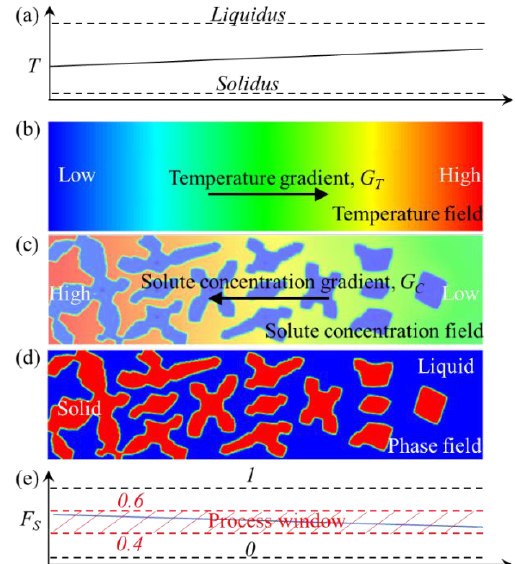
Figure 1. Schematic illustration of microstructure evolution under temperature gradient in mushy zones, ( a ) temperature distribution, ( b ) temperature field, ( c ) concentration distribution, ( d ) phase-field and ( e ) fraction solid and suitable process window of fraction solid for semi-solid die casting.